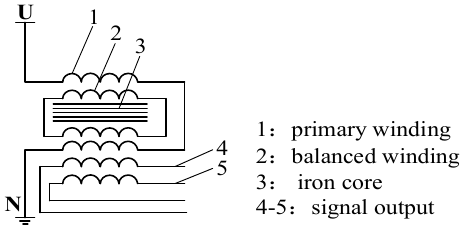
Figure 2. Potential transformer.